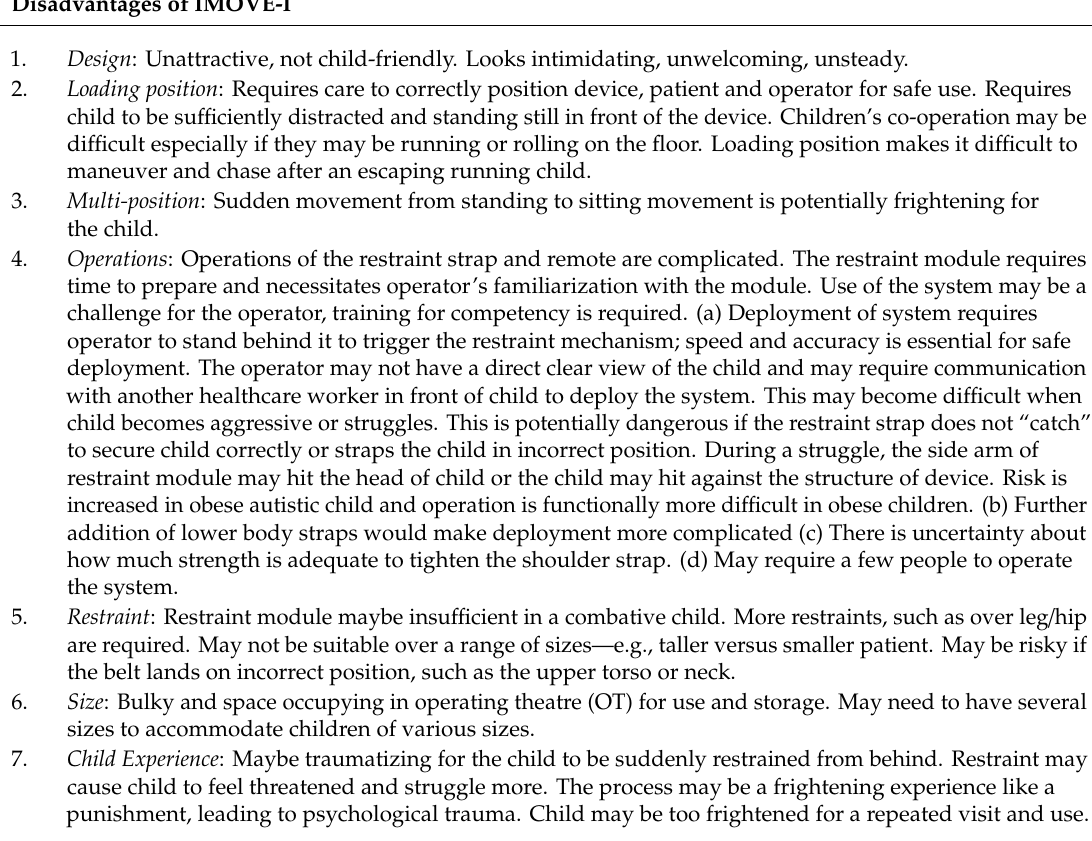
Table 4. Summary of disadvantages of both IMOVE-I and IMOVE-II